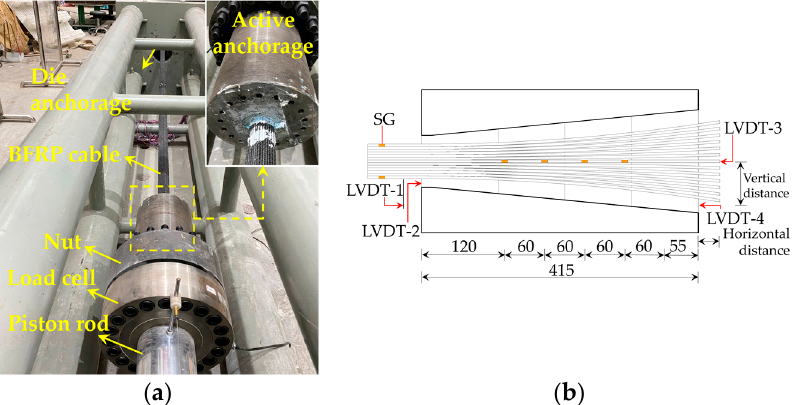
Figure 11. Loading and measurement schemes: ( a ) loading device and ( b ) measurement arrange-